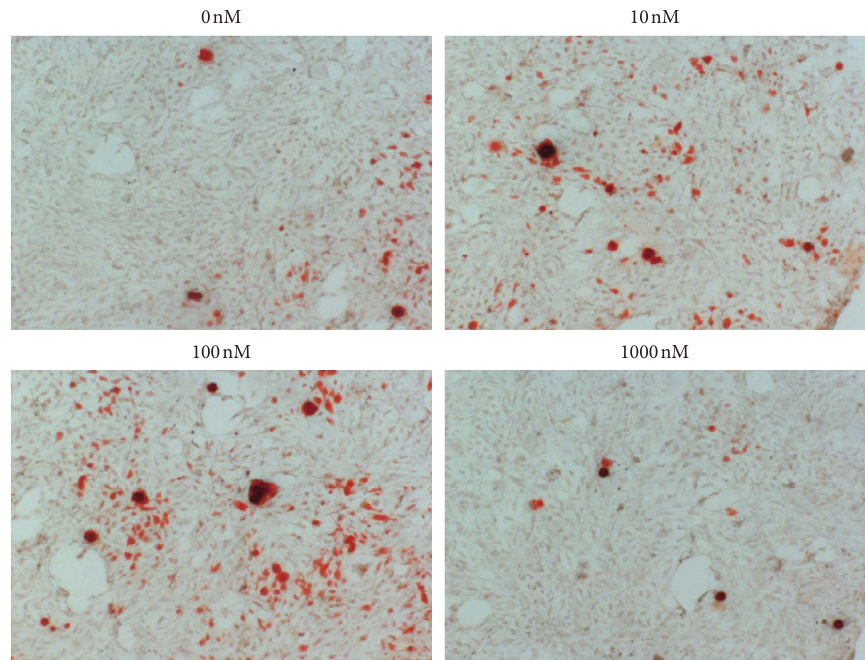
Figure 3: The mineralization effect of liraglutide was evaluated by alizarin red staining. MC3T3-E1 cells were cultured for 14 days and mineralization nodules, which are red were detected under a microscope.